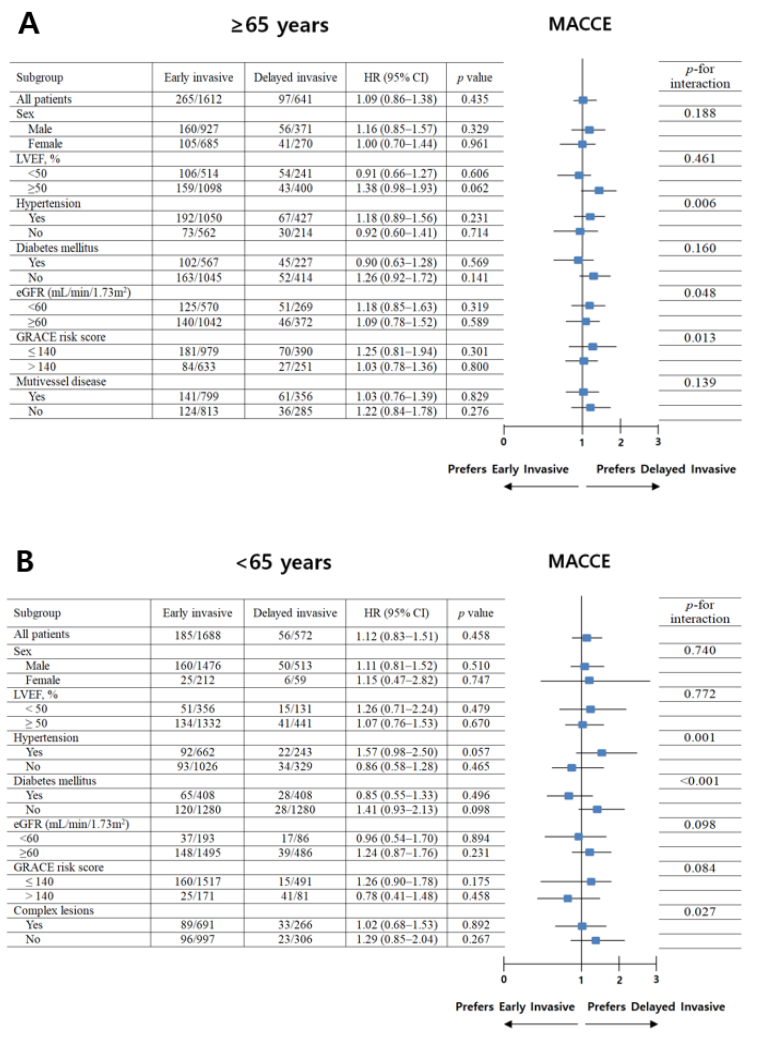
Figure 4. Subgroup analysis for MACCE in older ( A ) and younger ( B ) adults. MACCE, major adverse cardiac events; HR, hazard ratio; CI, confidence interval; LVEF, left ventricular ejection fraction; eGFR, estimated glomerular filtration rate; GRACE, Global Registry of Acute Coronary Events.